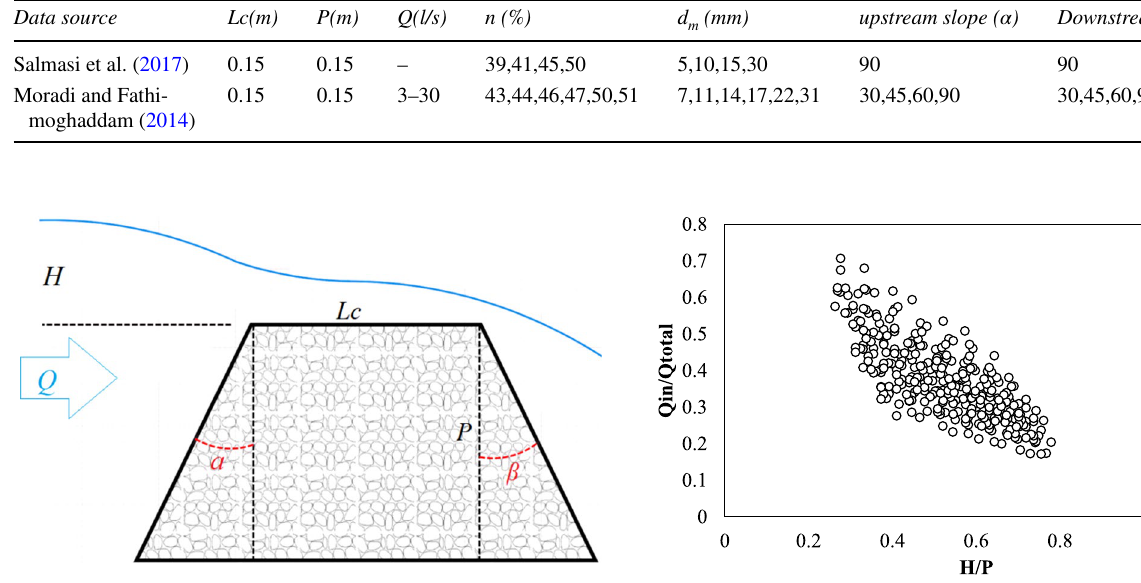
Fig. 1 Schematic view of the gabion weir parameters